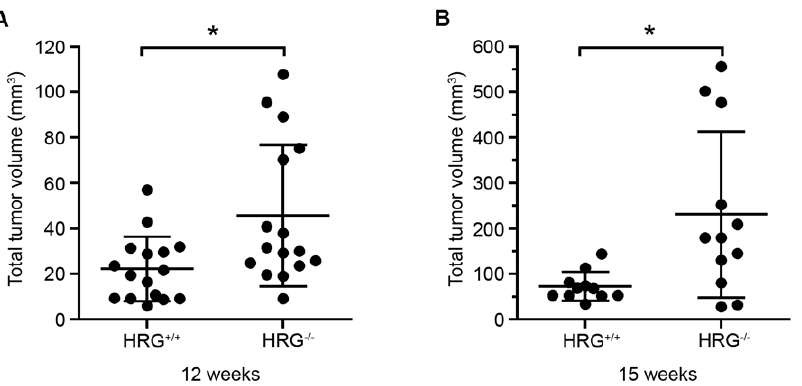
Figure 2. Tumor volume is increased in RT2/HRG 2 / 2 compared to RT2/HRG + / + mice. Tumors were dissected and measured. Tumor volumes were calculated by the formula (( p /6) 6 width 2 6 length). Each dot represents the summarized tumor volume in mm 3 from one mouse at (A) 12 weeks of age (n + / + =16; n 2 / 2 =16) and at (B) 15 weeks of age (n + / + =11; n 2 / 2 =12). Statistical analyses were performed with a two-tailed Mann-Whitney test, vertical bars represent standard deviation, * p # 0.05.